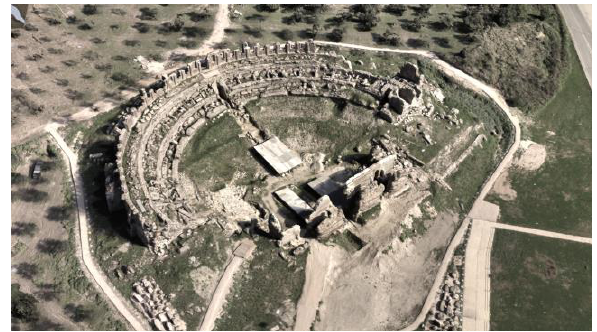
Figure 12. 3D rendering of the current state of the theatre.